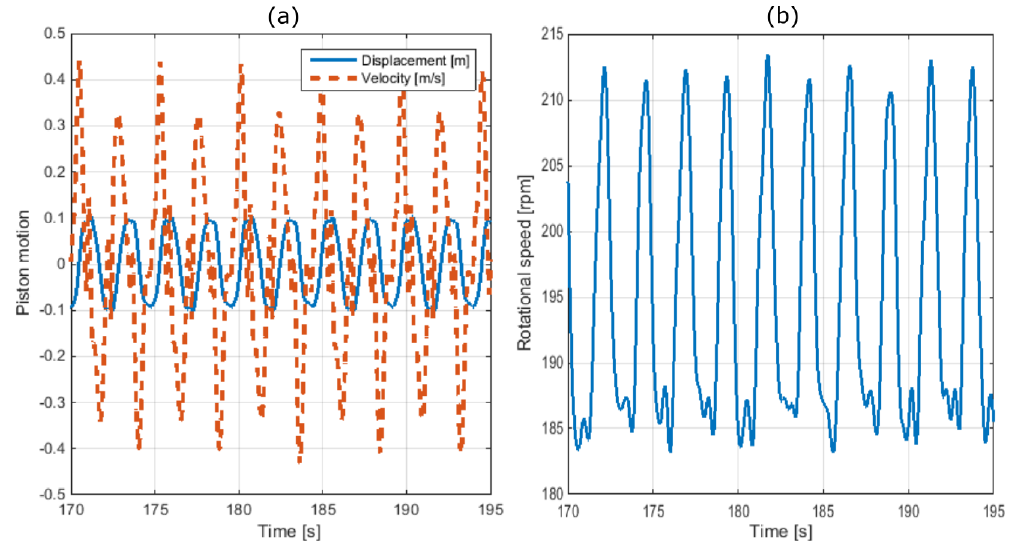
Figure 12. Inputs for the mathematical model: ( a ) position and velocity of the piston; and ( b ) rotational speed of the electrical